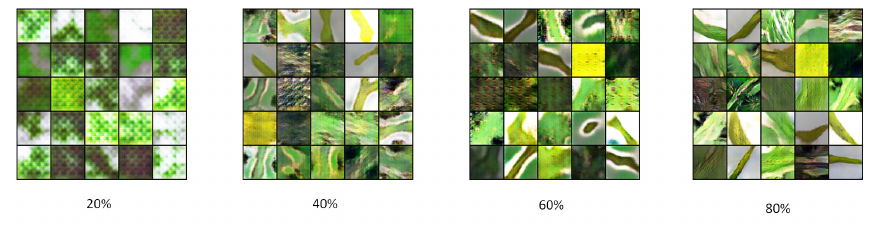
Figure 13. Effect of reducing the number of training sets on PWGAN-GP.